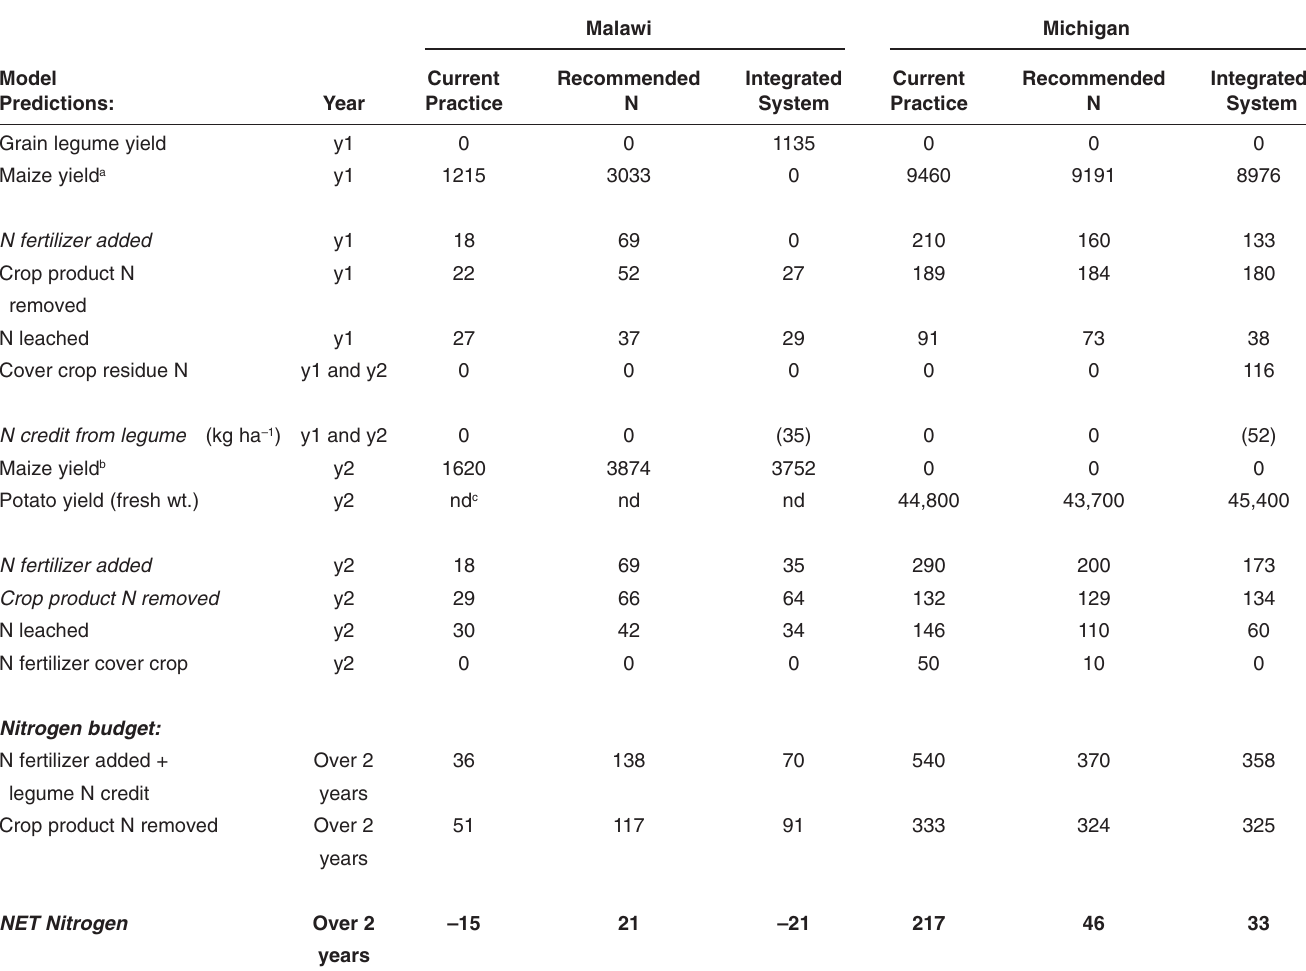
Simulated Crop Yield and N Data from Malawi and Michigan, Comparing Three Different Systems